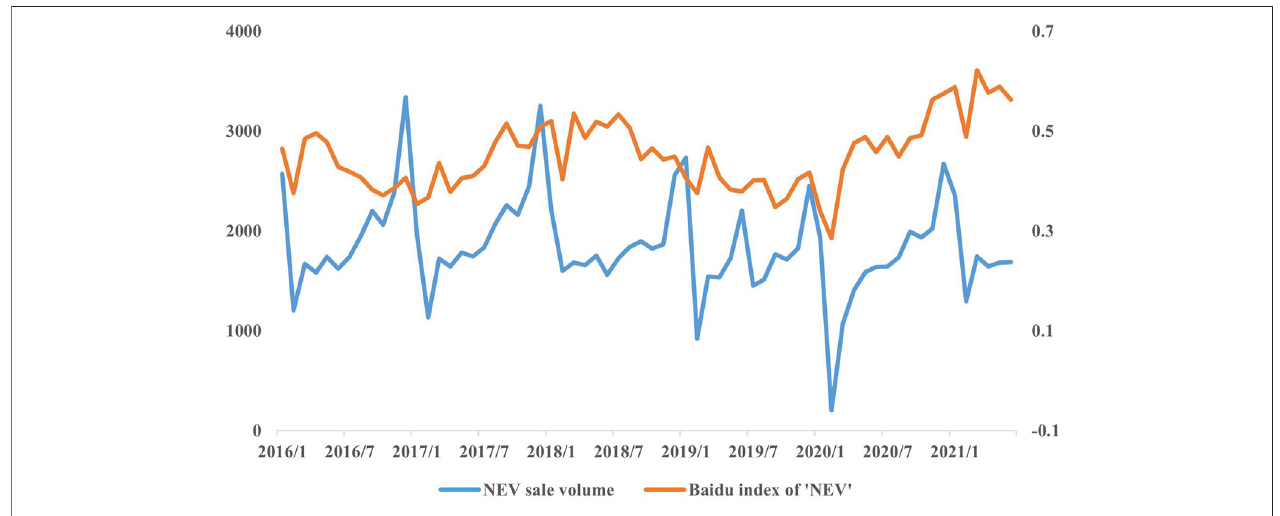
FIGURE 1 | New energy vehicle sales and Baidu search index in China from 2016 to